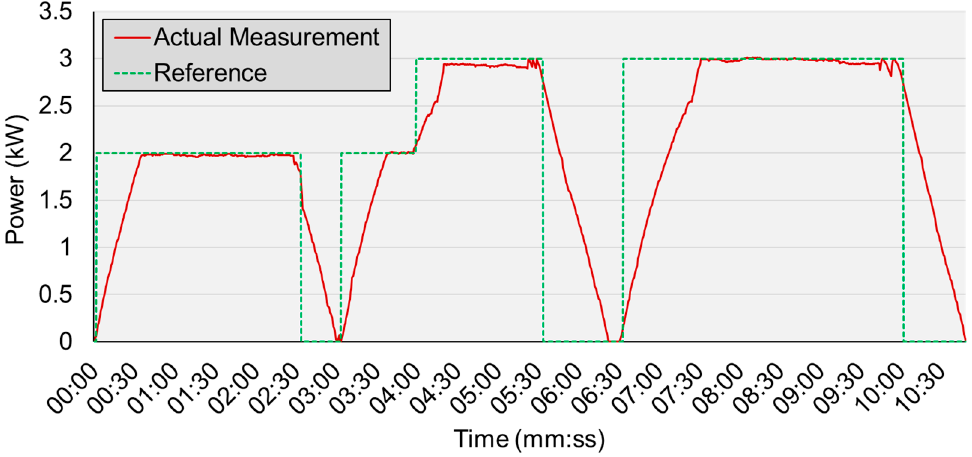
Figure 12. Generation profile of the syn. gen. emulator.